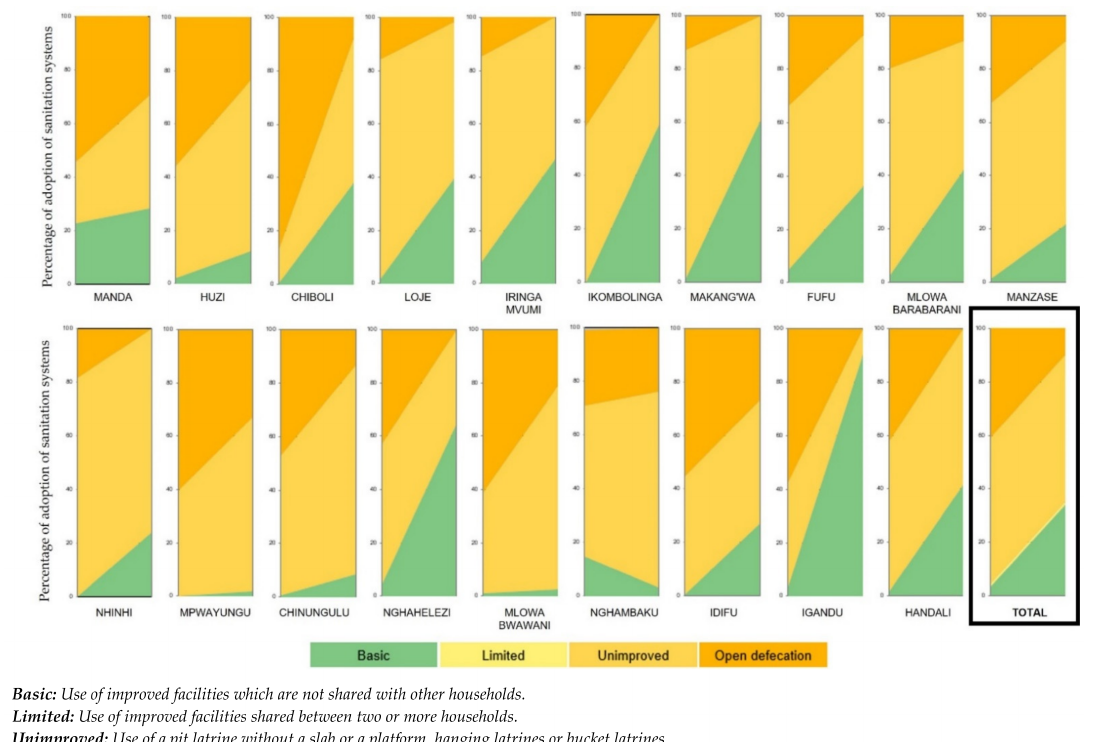
Figure 6. Percentage of adoption of each type of latrines within the sanitation ladder in the 19 wards surveyed in the Chamwino District before (baseline) and after (follow-up) the Programme.